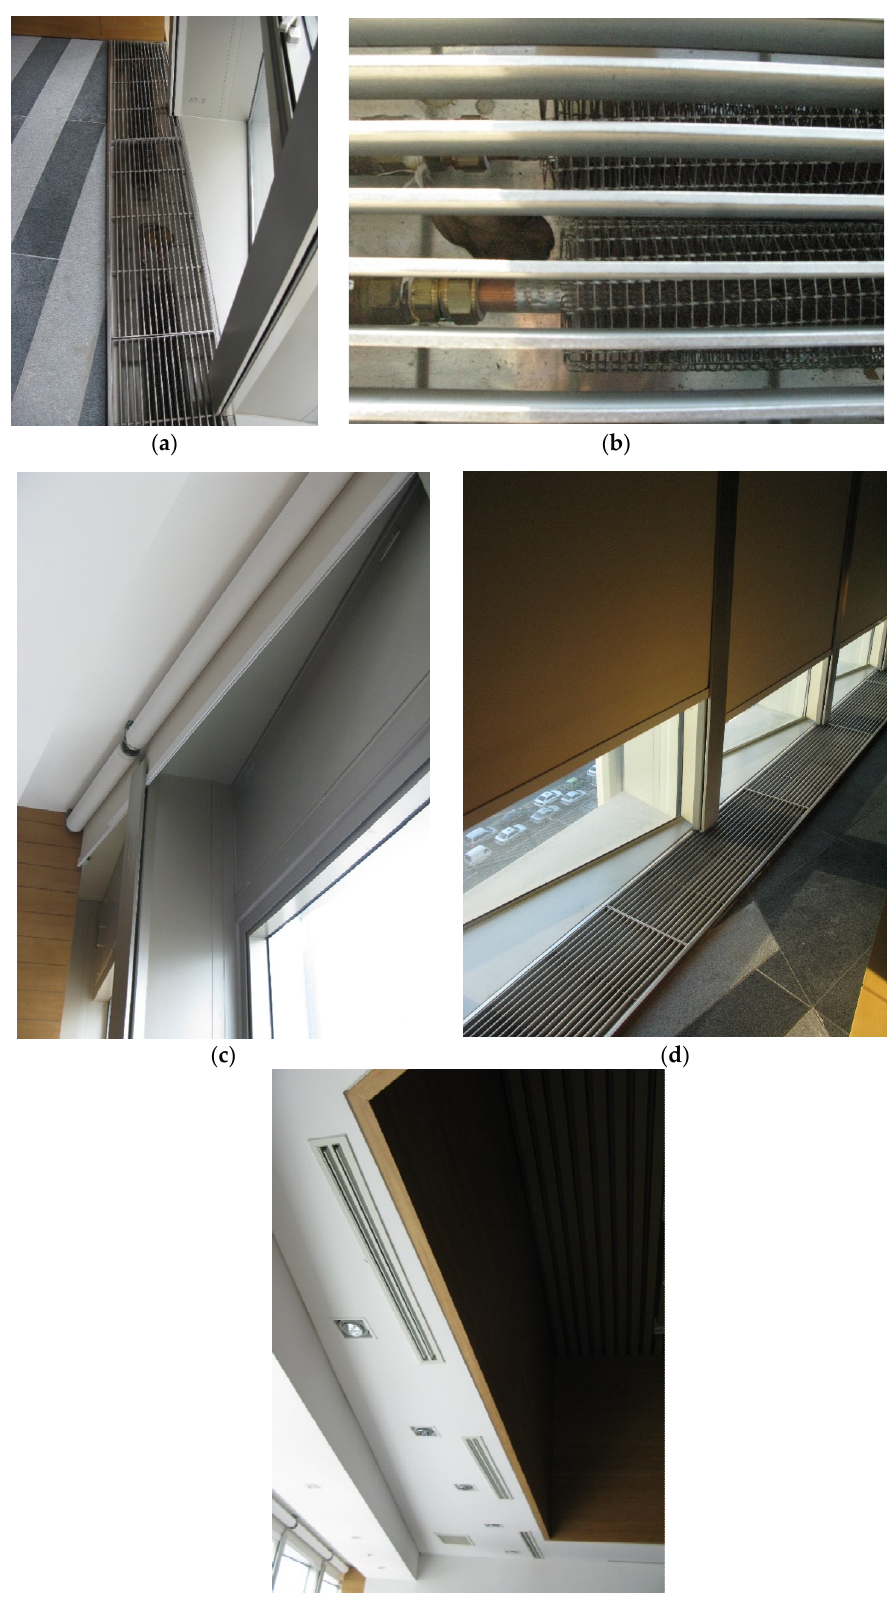
Figure 8. The components of the air barrier system: ( a ) the underfloor air distribution system; ( b ) D FPU in the underfloor air distribution system; ( c ) roller blind: open; ( d ) roller blind: closed; ( e ) EA vents in the ceiling.